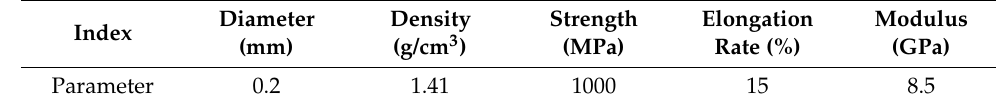
Table 2. Material properties of fly ash.